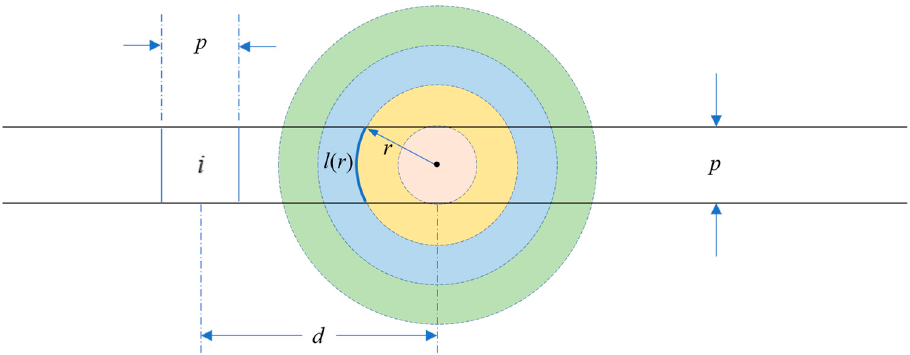
Figure 5. Relationship between the energy distribution of the diffraction pattern and pixels.